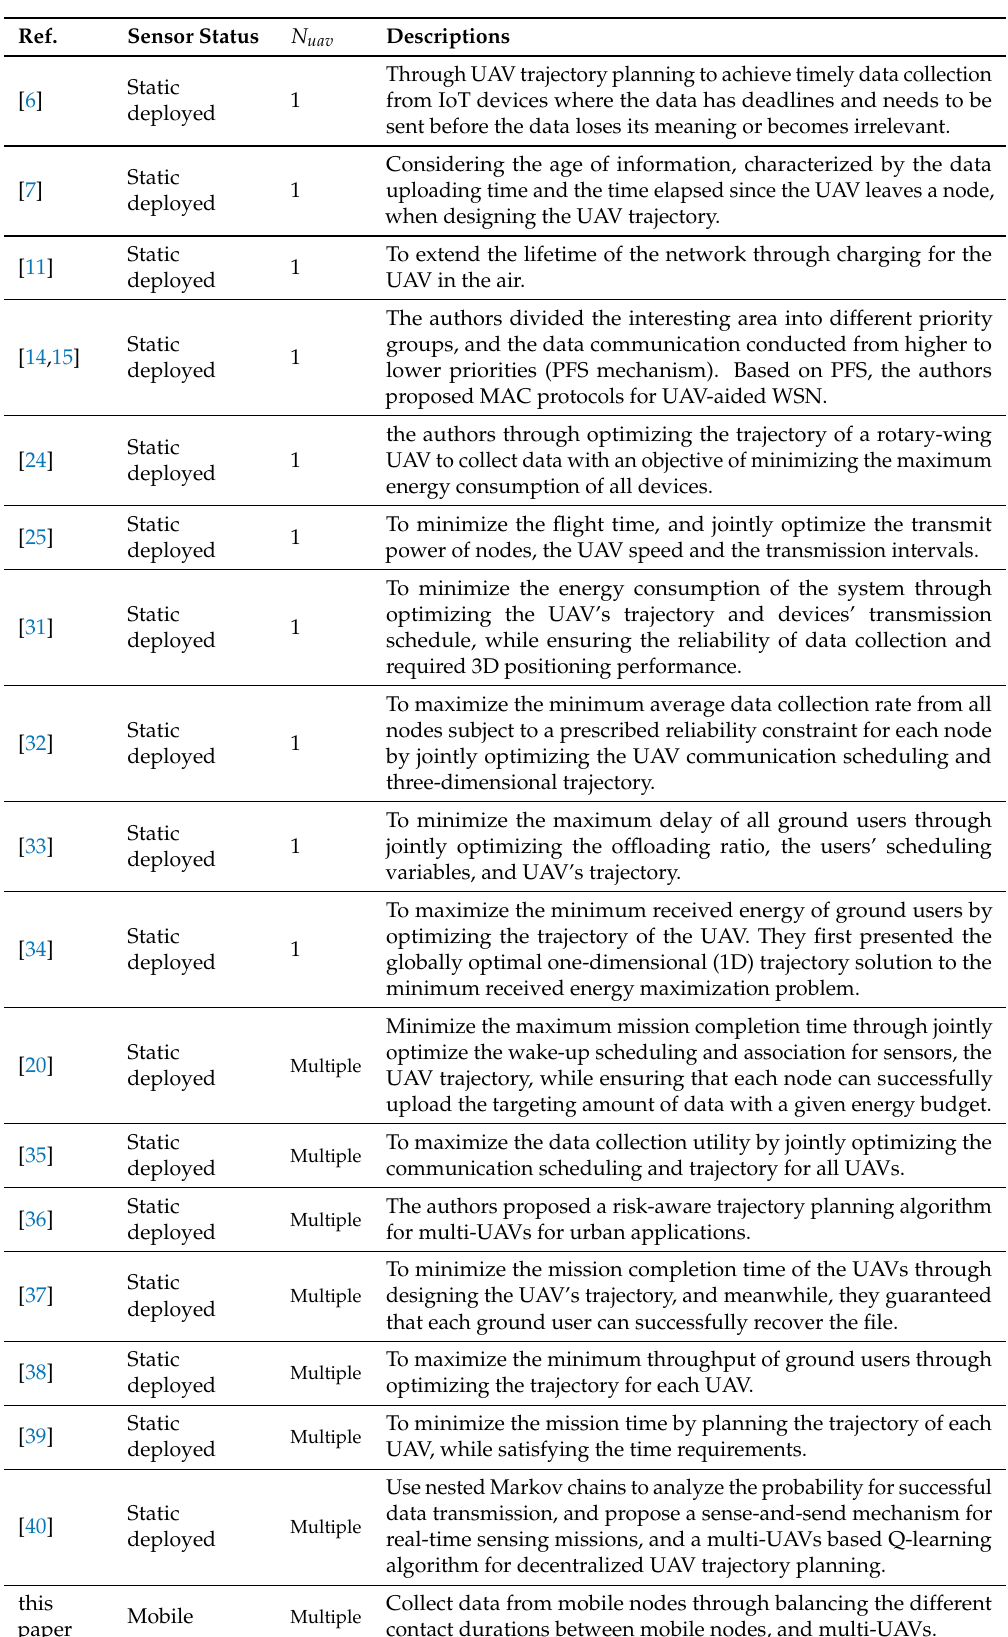
Table 1. Summary of related